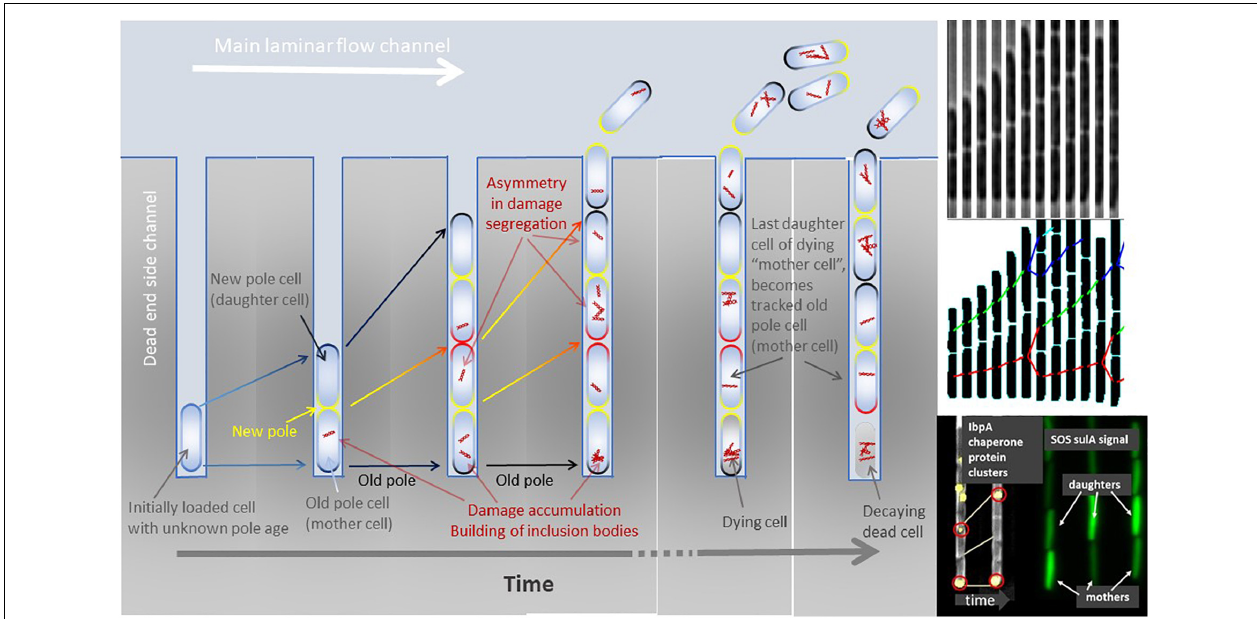
FIGURE 1 | Left panel: Cartoon of a mother machine channel across time. The initial loaded cell (left most channel in the panel) is of unknown cell wall age and polarity. After its first division, a new cell wall is built at the mid cell planar plane and becomes the new pole (yellow). The opposite cell poles define the old poles (dark). Pole age increases with time and division (yellow new pole, red poles built at previous division, black poles built at least two divisions ago). Over multiple divisions, the cell with the oldest pole remains at the bottom of the dead-end side channel and can be tracked until it dies, decays, and finally dissolves. Other cells than the bottom-most cell are pushed out of the side channels and washed away by the laminar flow. Damage, illustrated by red intracellular structures, accumulates throughout the life of a cell and can be purged by asymmetric division. Damage repair and recycling is not visualized here. Once the bottom-most old pole cell (mother cell) dies, its last produced daughter cell becomes the new cell that can be tracked throughout its lifespan. Right top and middle panels: Time sliced growth and division of bacteria cells growing in a dead-end side channel of a mother machine (phase contrast images top) and its lineage tracking with divisions after image analysis ( middle panel ). Right bottom panel: Examples of asymmetric division of fluorescently marked protein clusters (IbpA chaperones) and asymmetric segregation of transcription factor signal related to SOS stress response (sulA) among old pole (mother) and new pole (daughter)